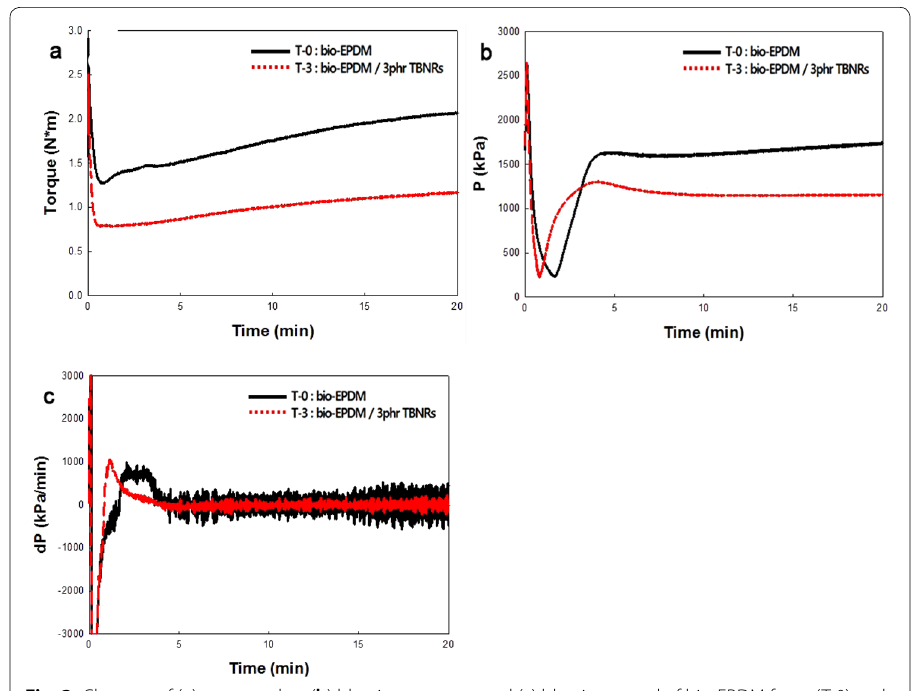
Fig. 3 Changes of ( a ) torque value, ( b ) blowing pressure, and ( c ) blowing speed of bio‑EPDM foam (T‑0) and bio‑EPDM foam with TBNRs (T‑3)